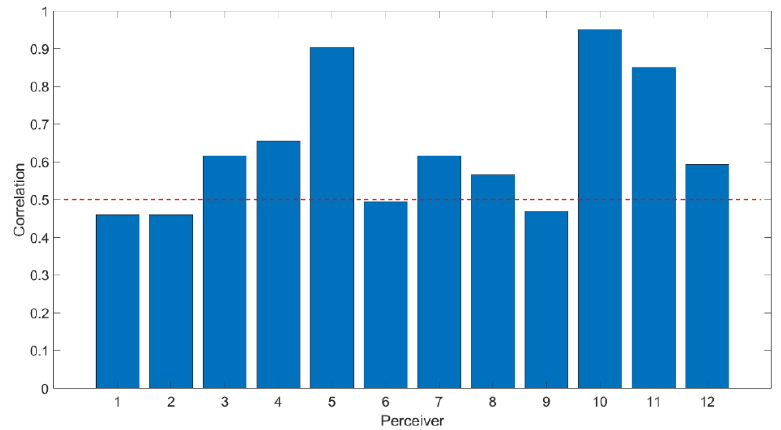
Figure 9. Correlation of the participants’ facial affective states and the ground truth over all trials. The average is 0.5 marked with the red dashed line.